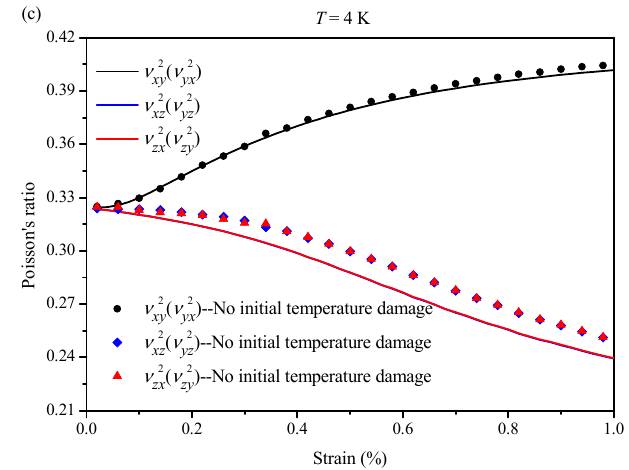
Figure 11. EAS-Nb 3 Sn level 2 homogeneous superconducting region considering damage in different directions when T = 4 K: ( a ) Young’s modulus; ( b ) shear modulus; ( c ) Poisson’s ratio. (Note: The symbol “2” indicates the level 2 homogeneous core bundle).